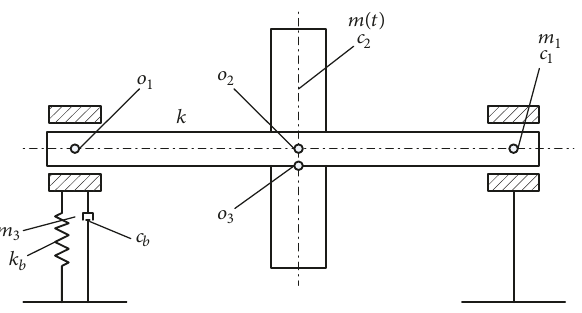
Figure 1: Bearing-rotor system with single pedestal